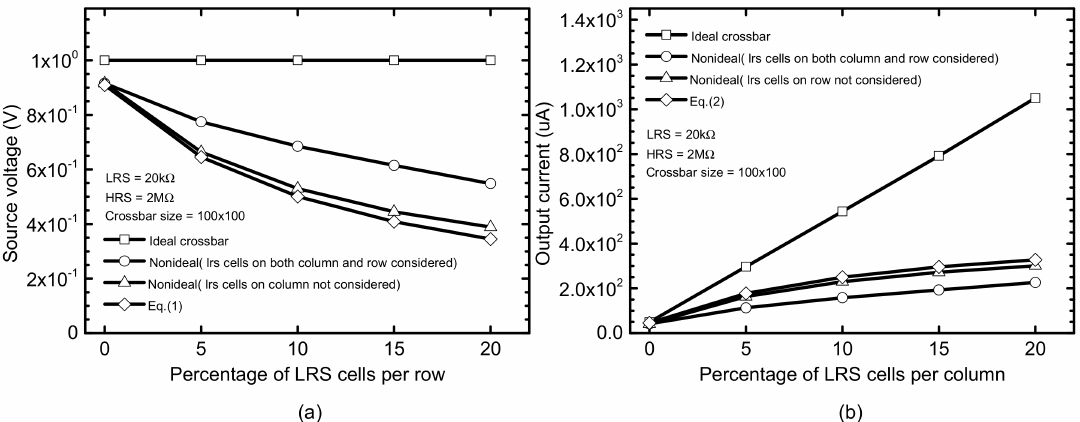
Figure 2. ( a ) Comparison of the source voltage of the ideal crossbar, the nonideal one (LRS cells on both column and row considered), the nonideal one (LRS cells on a column not considered), and the calculation with Equation (1). ( b ) Comparison of the output current of the ideal crossbar, the nonideal one (LRS cells on both column and row considered), the nonideal one (LRS cells on row not considered), and the calculation with Equation (2). Here, the ideal crossbar is assumed zero parasitic resistance. The nonideal crossbar is assumed with R S = 2 k Ω , R N = 2 k Ω , and R W = 1 Ω . The ideal and nonideal crossbars are simulated with a CADENCE SPECTRE version 6.1.6 circuit